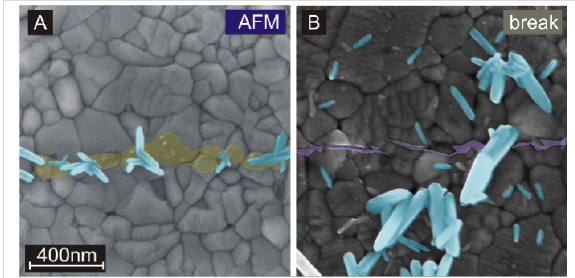
Figure 3: A) SEM image after short hydrothermal growth on a scratched line. The line is written only a few times in order to generate fewer growth sites compared to Figure 2. For clarity, nanorods are colored bluish and the scarified surface is colored yellowish. B) SEM image after applying several times the hydrothermal growth to a stress-induced line of breakage. For clarity, the breaking line is colored purple. The breaking line does not specifically promote the growth of nanorods. Nanorods growing around the breaking line might originate from anatase nanoparticles released during the breaking process.